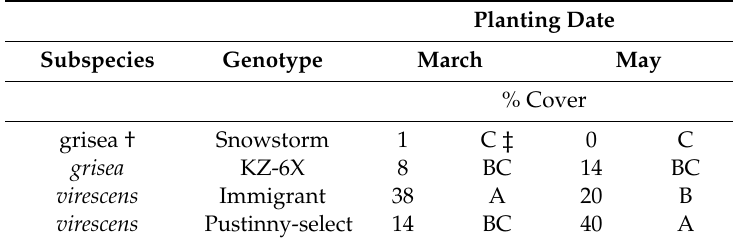
Table 2. Canopy cover percentages of Bassia prostrata (L) A.J. Scott by genotype and planting date (in 2014). Data are the means of ratings taken 2 and 4 years after planting (no year e ff ect or interaction with year, p < 0.6093 and p < 0.9498, respectively) and 3 replicates.